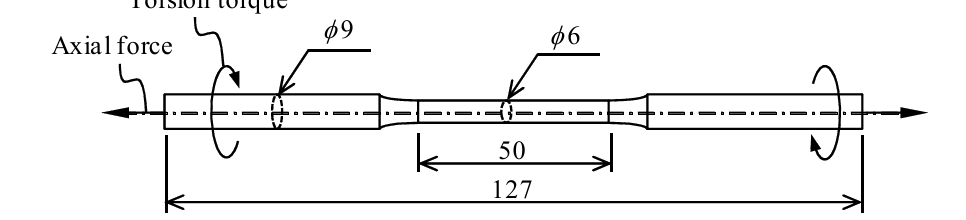
Figure 1: Tension-torsion test specimen